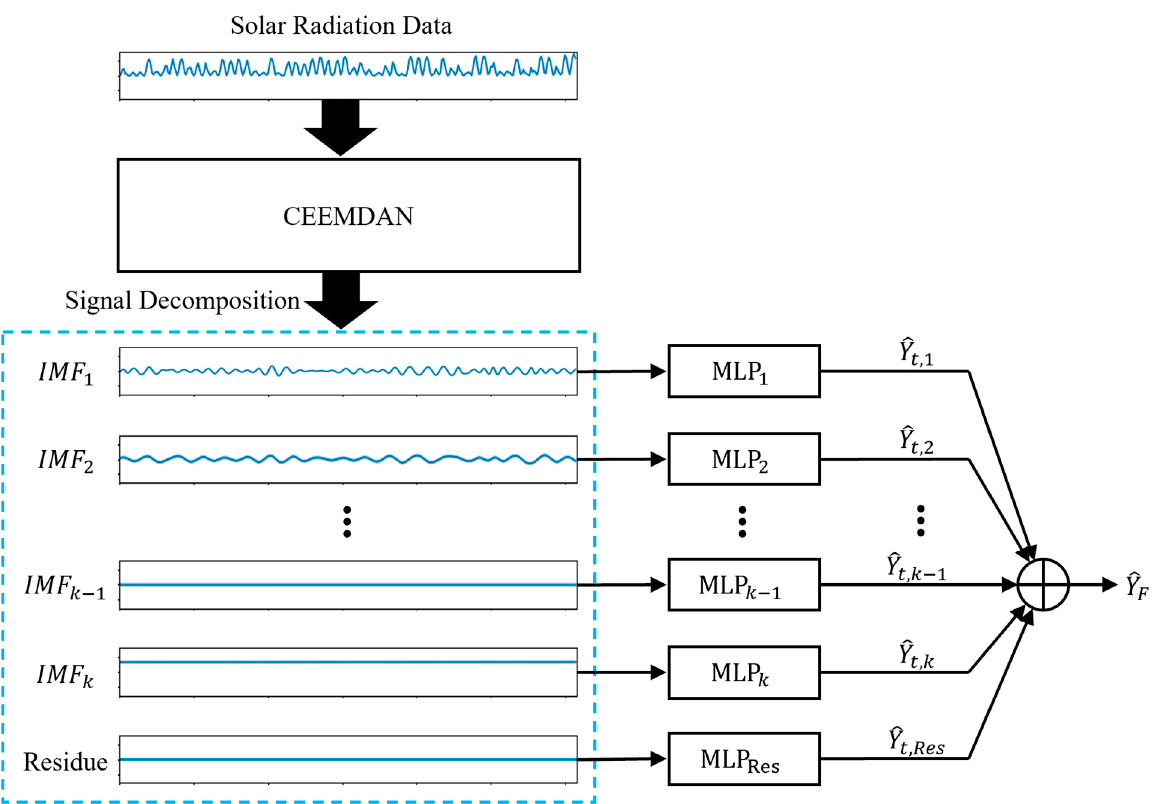
Figure 5. Structure of the day-ahead solar radiation forecasting model in the frequency domain.